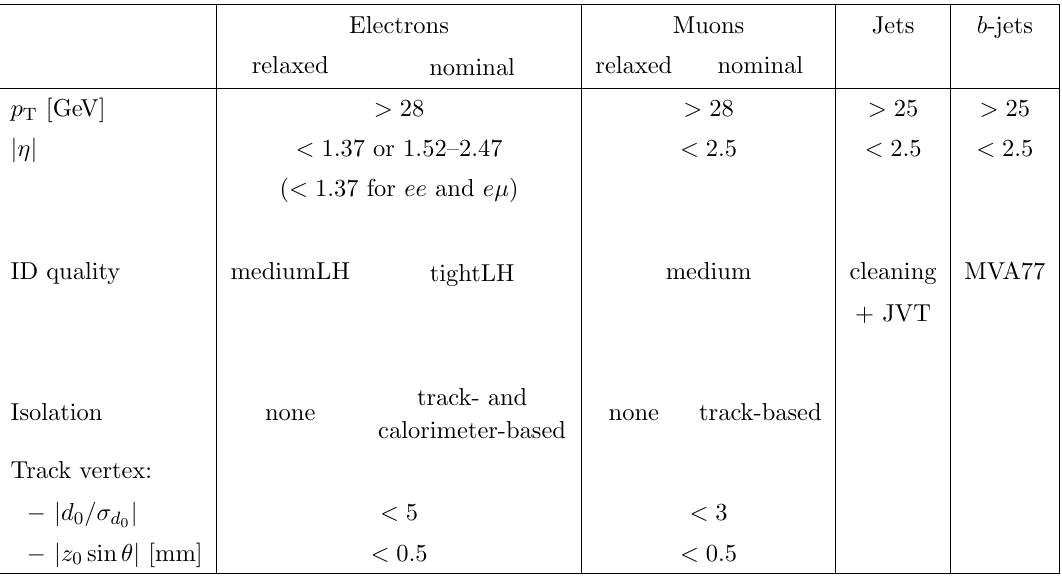
Table 1 . Summary of object identi(cid:12)cation and de(cid:12)nition. ‘ID quality’ refers to the identi(cid:12)cation criteria used for each object type. For electrons, ‘mediumLH’ and ‘tightLH’ refer to the likelihood medium and tight requirements de(cid:12)ned in ref. [33]; for muons the criteria for ‘medium’ ID quality are de(cid:12)ned in ref. [34]. For jets, ‘cleaning’ means applying a procedure to reduce contamination from spurious jets [36], and ‘JVT’ means applying criteria to select jets that are consistent with being produced at the primary vertex rather than from pile-up [37]. For b -jets, ‘MVA77’ refers to placing a requirement on the multivariate discriminant de(cid:12)ned in ref. [38] that is 77% e(cid:14)cient for b -jets in simulated t (cid:22) t